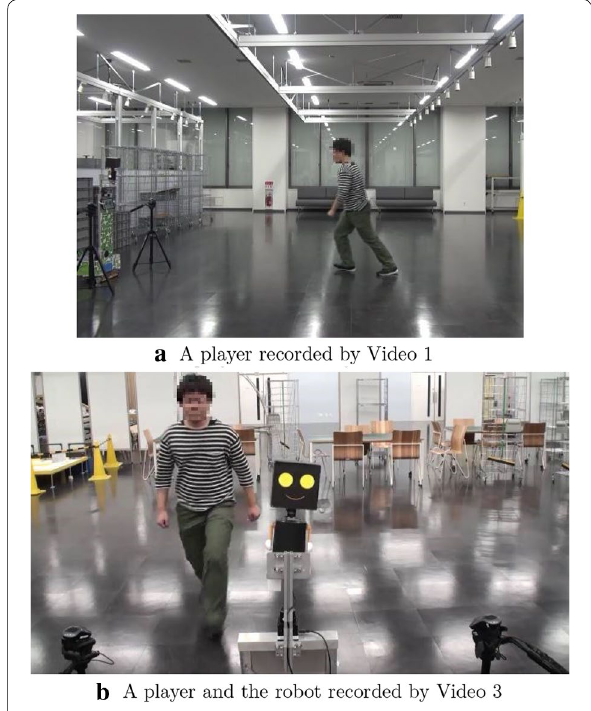
Fig. 24 Evaluation experiment of the total